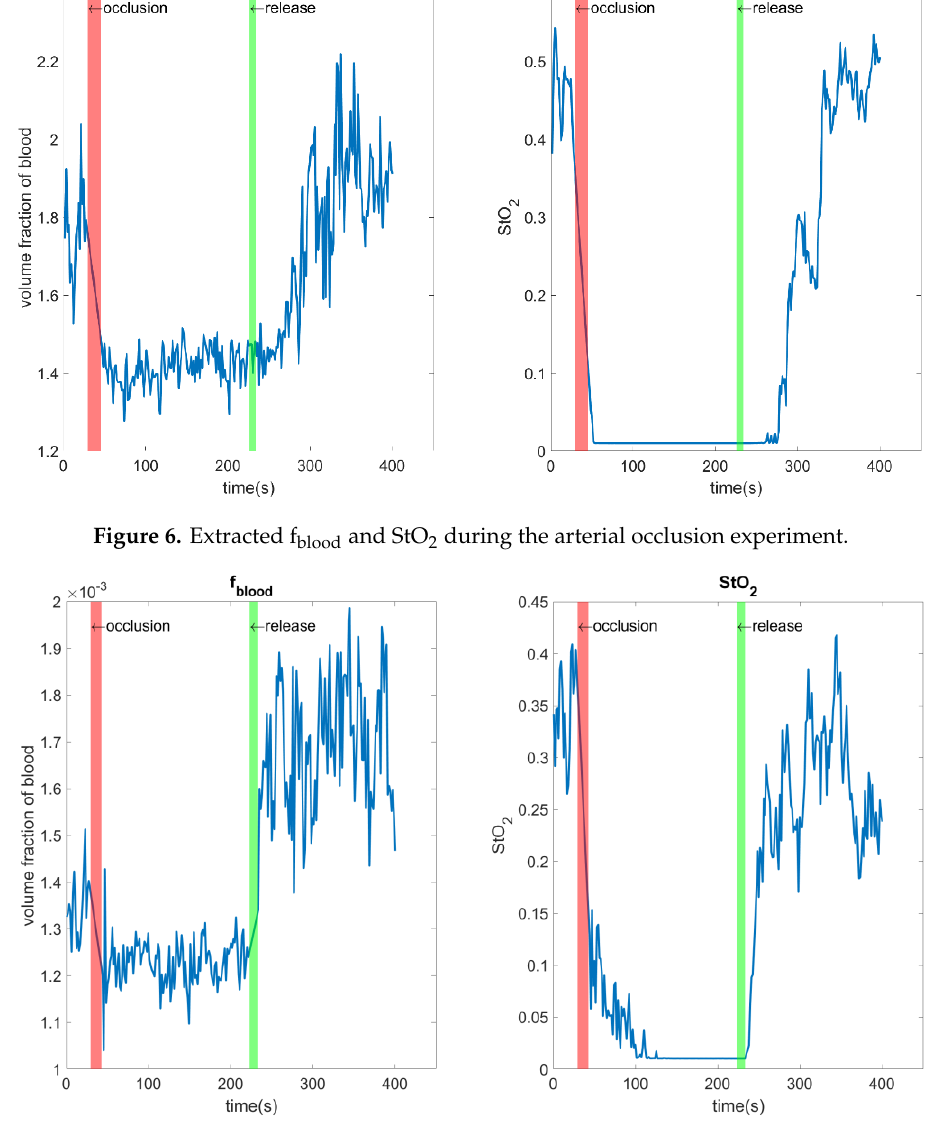
Figure 7. Extracted f blood and StO 2 during the venous occlusion experiment.